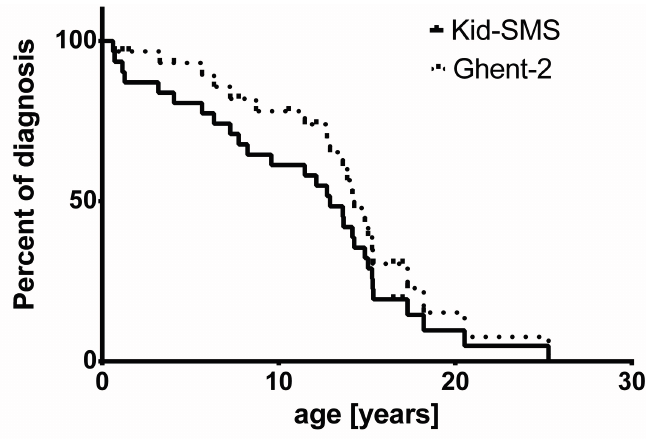
Figure 2. Kaplan-Meier analysis of age of diagnosis with Ghent-2 (Revised Ghent Criteria, dashed line) and risk stratification of MFS (very high risk, high risk, moderate risk) with Kid-SMS (Kid-Short Marfan Score, continuous line), p = 0.2,